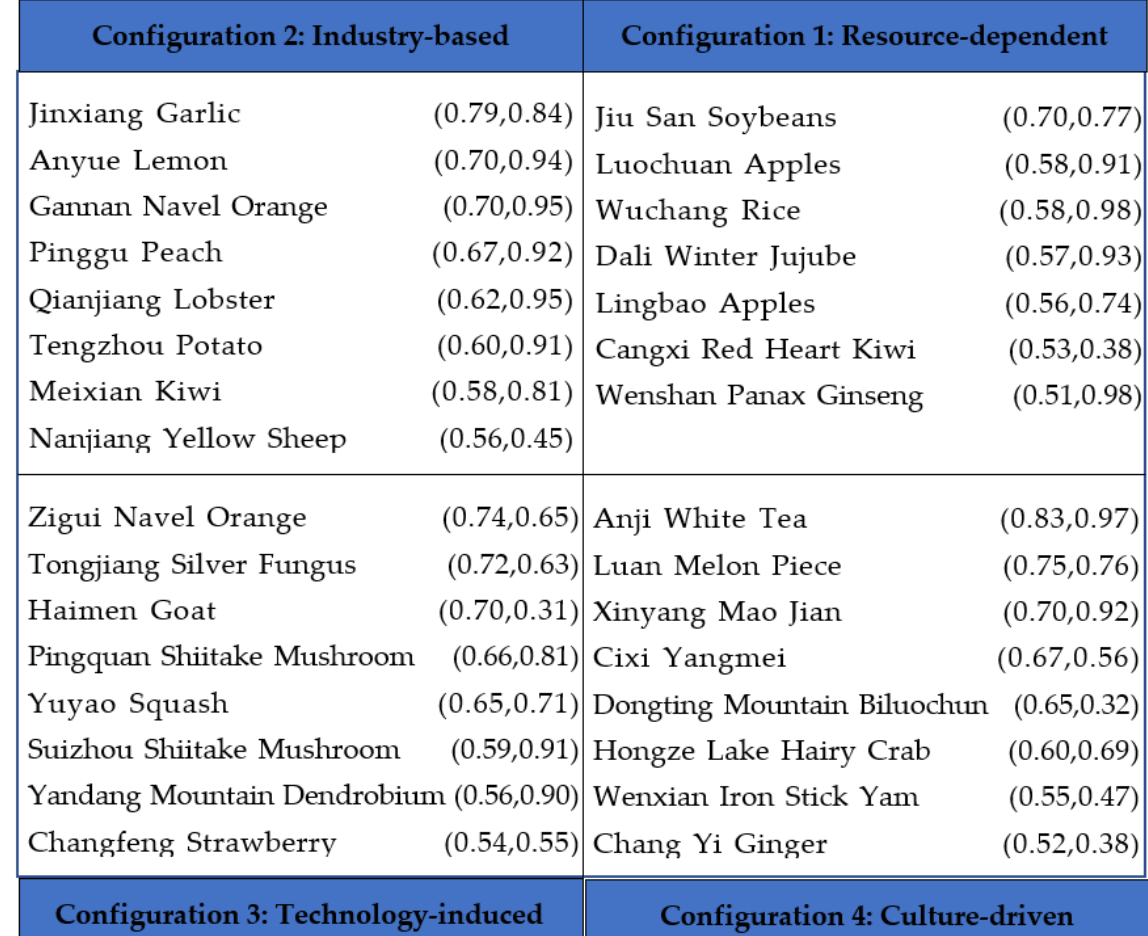
Figure 4. Distribution of brand samples on the four configurations (driving modes) . Note: cases include (affiliation in the set of conditions; affiliation in the set of results).